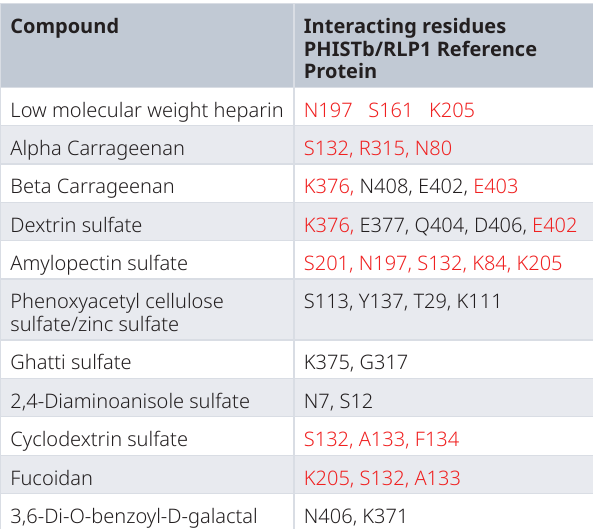
Table 8. Specific residue interactions of the drug compounds and the PHISTb/RLP1 reference protein structure as visualized in PyMOL by showing polar contacts. The highlighted residues show optimized interactions with amino acids that were predicted by the binding site predicting tools. Alpha carrageenan, beta carrageenan, amylopectin sulfate, cyclodextrin sulfate and fucoidan compounds interacted specifically with amino acids predicted in binding sites of the reference protein structure. They showed potential ability to clock functional domains of PHISTb/RLP1